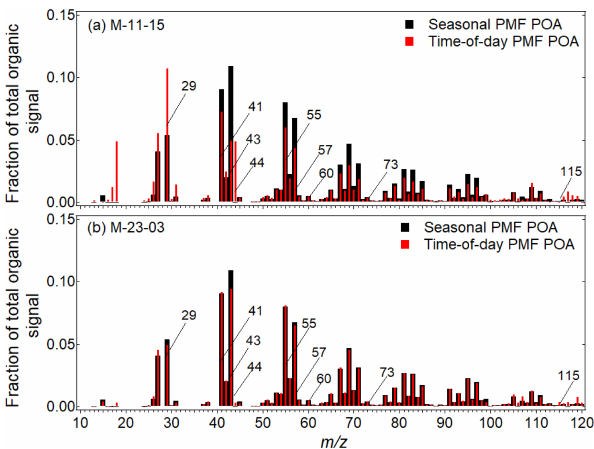
Figure 8. Mass spectra of time-of-day PMF POA and seasonal PMF POA for the periods (a) midday and (b) nighttime in the 2017 monsoon season. Midday MS show larger differences compared to nighttime